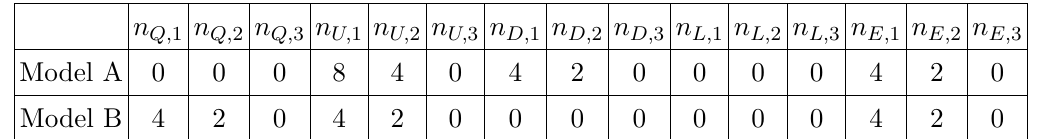
= n = 0, leading to a Q;i L;i = h = 0 u d